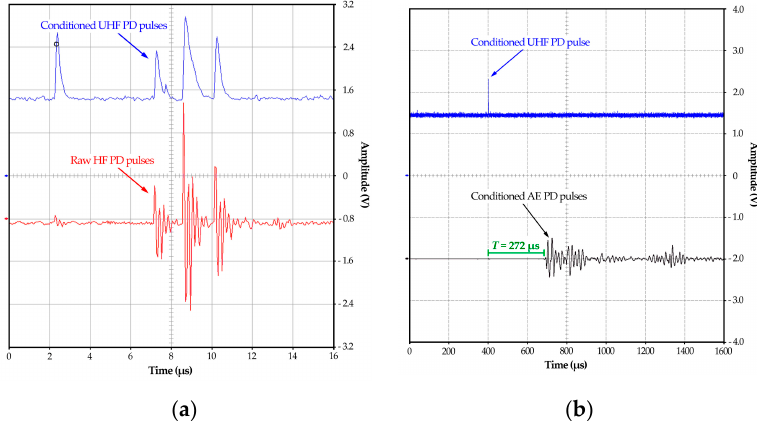
Figure 21. Exemplary time waveforms registered during laboratory tests of the PD signal conditioning modules: ( a ) conditioned UHF PD pulses and raw HF PD pulses, ( b ) conditioned single UHF PD pulse and conditioned acoustic emission (AE) PD pulses.